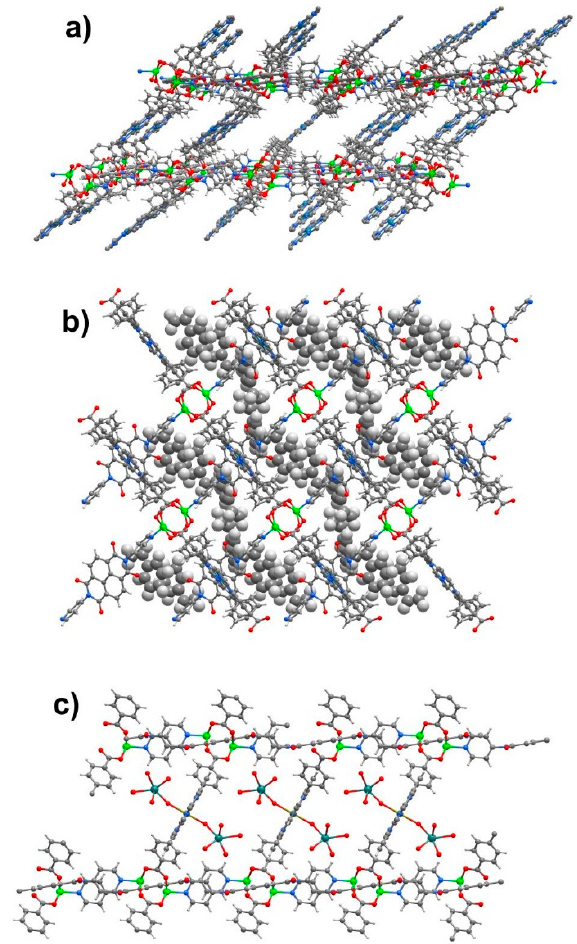
Figure 8. Crystal packing features of compounds ( a ) CZJ-1 viewed along [0,1,0] direction; ( b ) CZJ-1 ⊃ 2 styrene viewed along [0,0,1] direction; and ( c ) CZJ-1-Ti viewed along [0,1,0] direction. (Colour scheme: bright green = Zn, dark yellow = Mn, dark green = Ti, gray = H, dark gray = C, light blue = N, red = O).